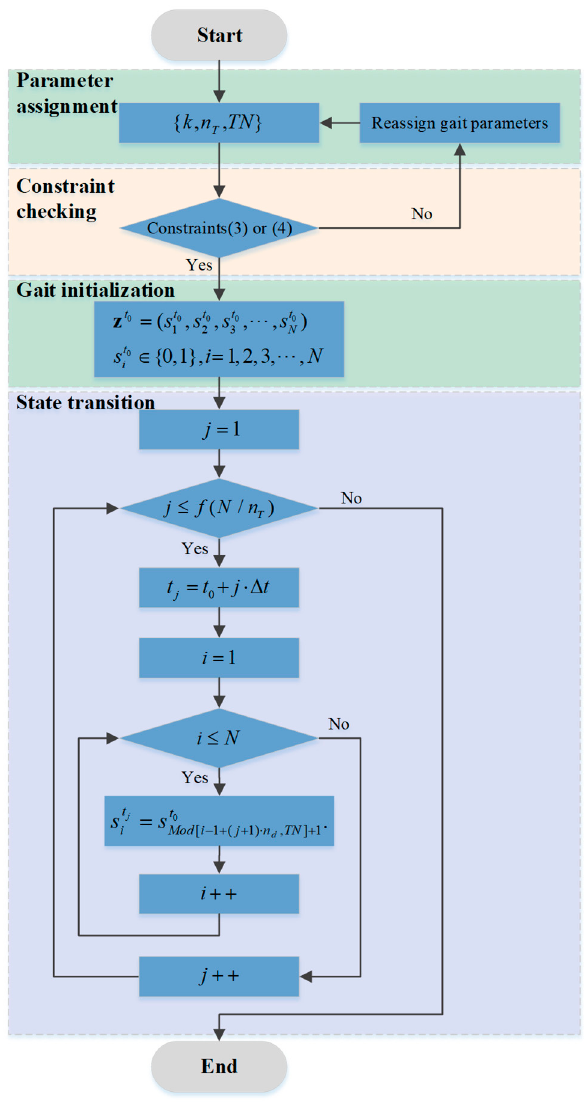
Figure 5. Routine of the generation algorithm for MG- Ⅰ .